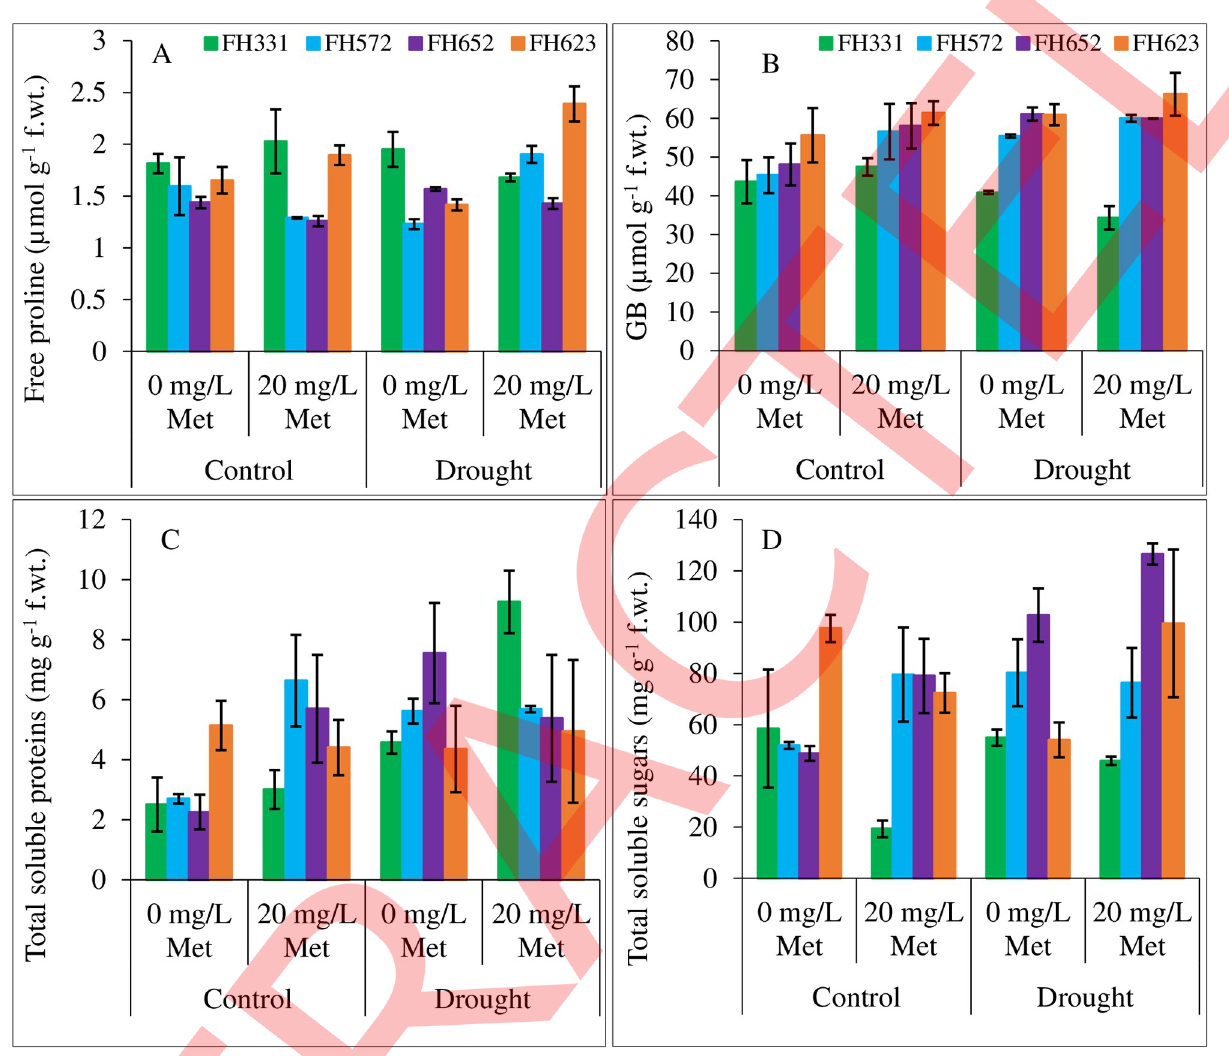
Fig 4. Effect of L-methionine on (A) free proline, (B) GB content, (C) total soluble protein and (D) total soluble sugars in sunflower ( Helianthus annuus L.) plants grown under water deficit condition (Mean ±